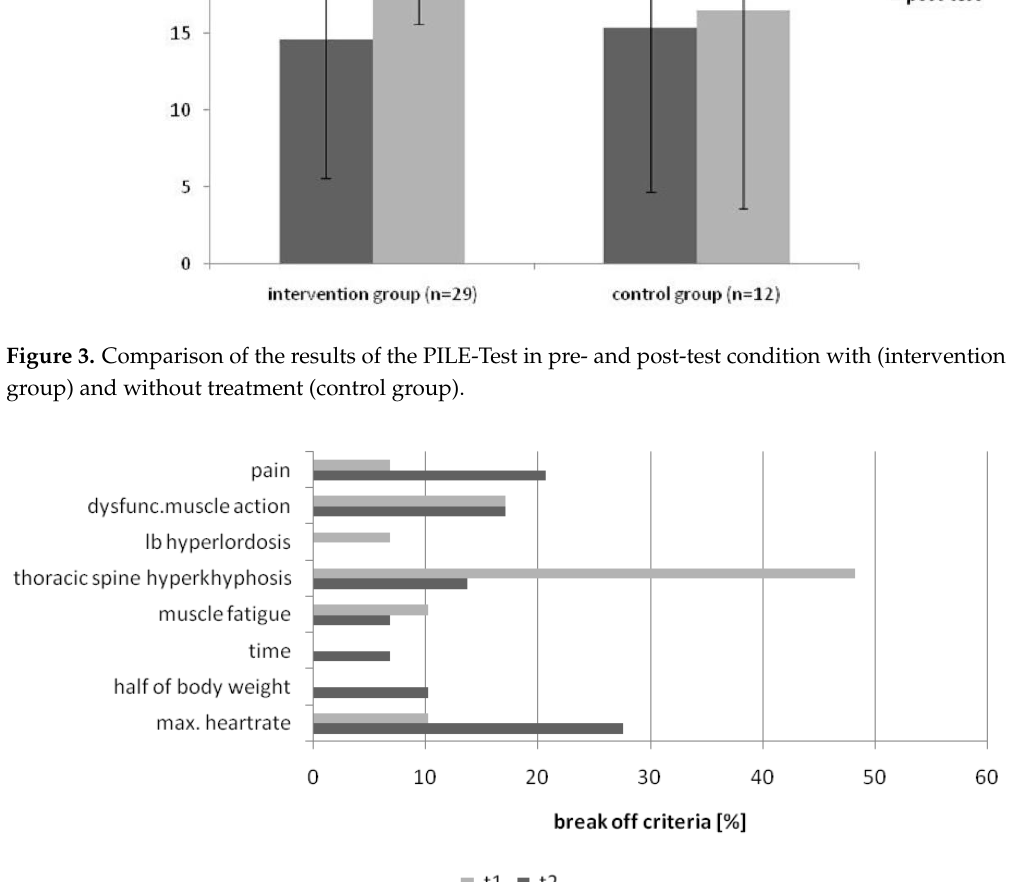
Figure 5. The cognitive representation of the box lifting technique displayed as average cluster solutions of the BACs 1–14 for the intervention and the control group at retention test. The numbers at the bottom represent the used BACs. The Euclidian distances between the BACs is indicated at the conjunctions between BACs. The lower the number at the conjunctions, the lower the Euclidian distances between these BACs. The lower the distance, the stronger the connection between these BACs in long-term memory. The dashed line represents the critical Euclidian distance (dcrit = 4.576 with an error probability of p = 0.01) where all branches of the dendrogram were cut-off. BACs connected to one branch below the critical Euclidian distance are clustered. Evolved clusters are indicated by grey bars at the bottom of each dendrogram. The cluster represented functional movement phases named below the grey bars.